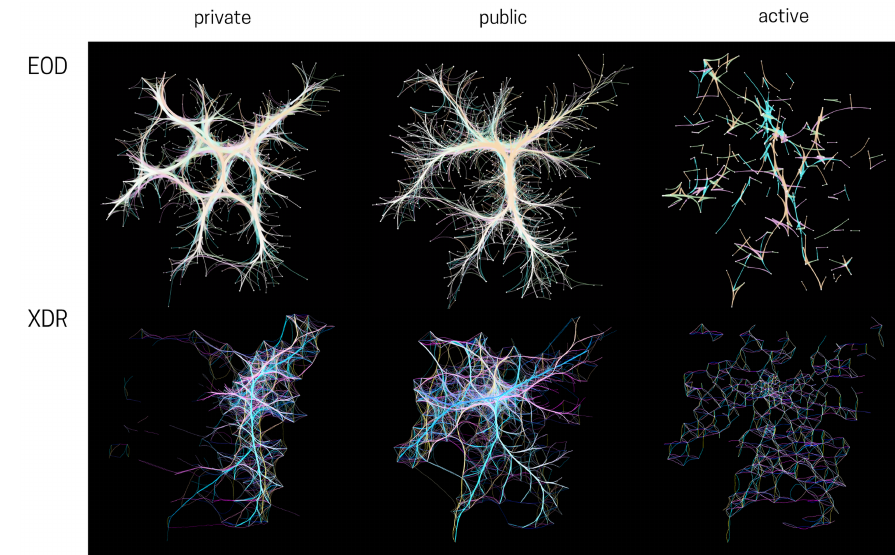
Figure 9. Comparison of survey ( EOD ) and pervasive ( XDR ) data with geographic bundling by mode of transportation.